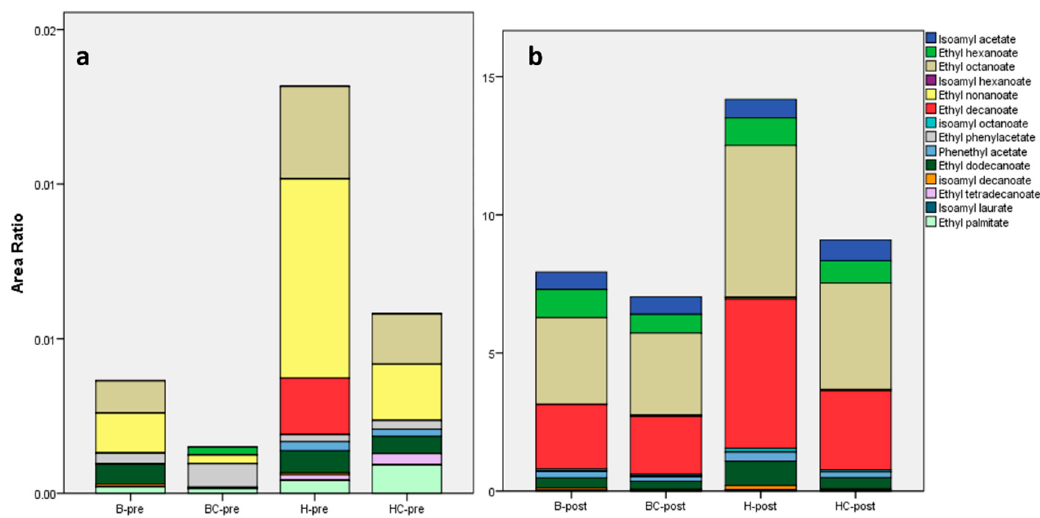
Figure 4. Esters composition in pre ( a ) and post ( b ) fermentation samples. Values represent the area ratio with the internal standard (n = 3). B-pre: blossom honey pre-fermentation; B-post: blossom honey post-fermentation; BC-pre: blossom honey with blackcurrant pre-fermentation; BC-post: blossom honey with blackcurrant post-fermentation; H-pre: honeydew honey pre-fermentation; H-post: honeydew honey post-fermentation; HC-pre: honeydew honey with blackcurrant pre-fermentation; HC-post: honeydew honey with blackcurrant post-fermentation.